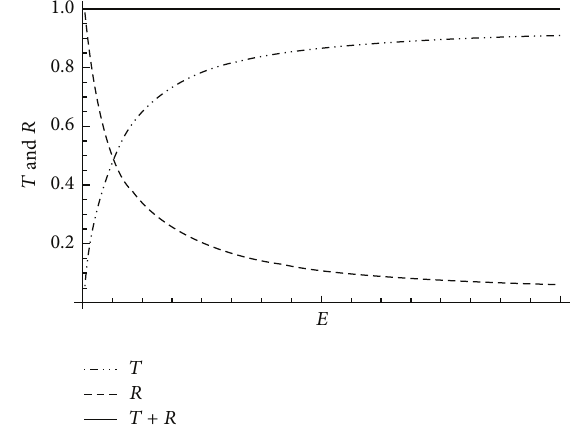
Figure 5: Transmission ( 𝑇 ) and reflection ( 𝑅 ) coefficients versus 𝐸 are